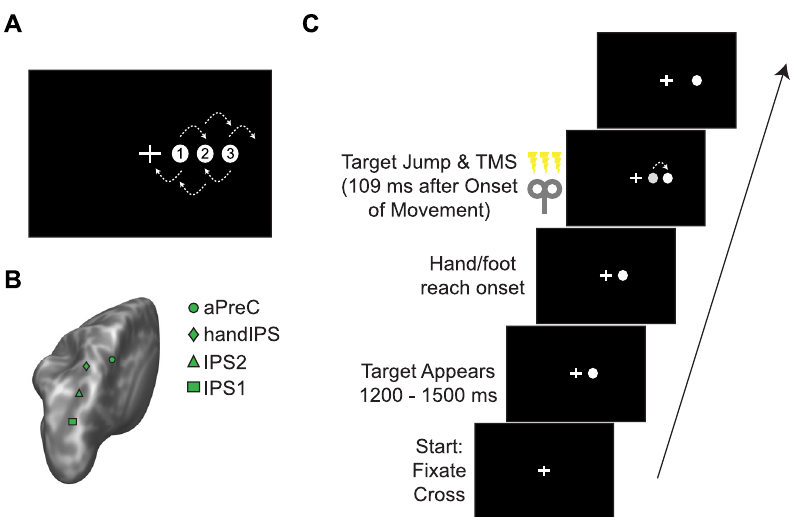
Fig 1. Experimental set-up and design. (A) A single target appeared in one of three positions to the right of midline. Participants initiated a hand or foot reach towards the target. Depending on the condition, the target remained in its position or it ‘jumped’ to the next position left or right after the participant had initiated the reach. (B) We applied transcranial magnetic stimulation (TMS) to one of four posterior parietal cortex locations in different blocks of trials, including a medial-caudal intraparietal sulcus region (IPS1), a medial intraparietal sulcus region (IPS2), handIPS, and the anterior precuneus (aPreC). We also applied sham TMS. (C) A trial began with participants fixating a central cross. The target appeared at random times between 1,200 and 1,500 ms. In 50% of trials, the target ‘jumped’ to a new location during movement. In 50% of jump and non-jump trials, we applied triple-pulse